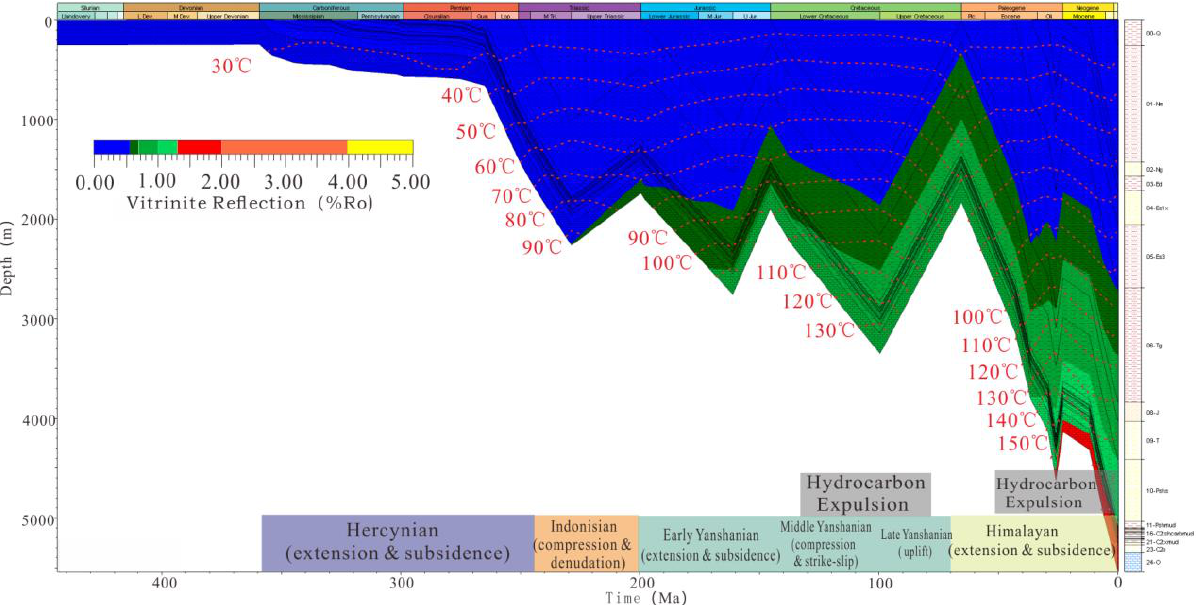
Figure 8. Tectonic events and burial – thermal history of strata in the Wumaying area.